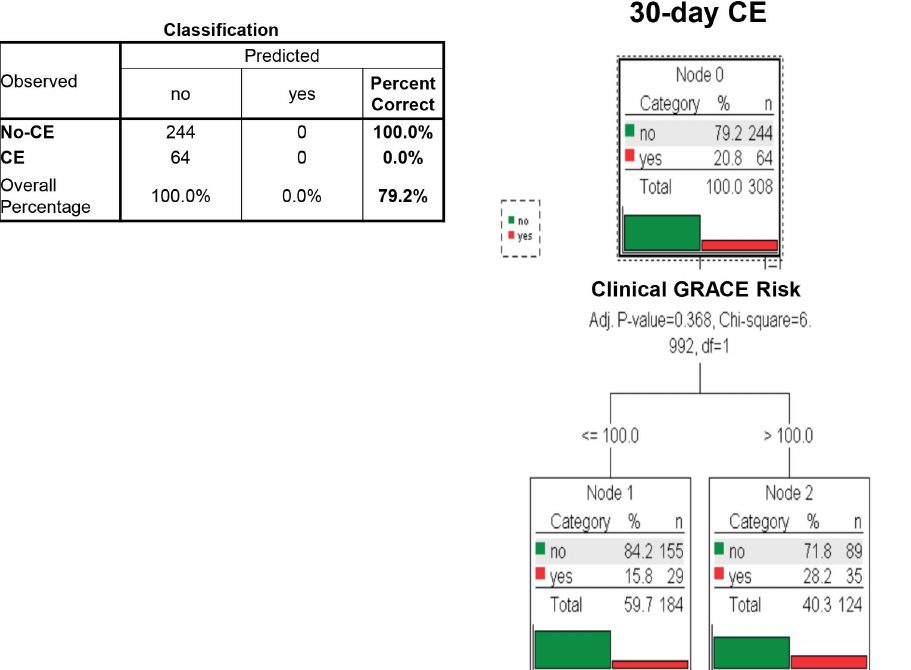
Figure 4. Multivariate classification tree analysis of clinical and multiple biomarker information and the resulting algorithm for the identification of those at risk of cardiac events (CE) within 30 days among patients presenting with suspected ACS and no apparent ST-segment elevations (Non-ST-elevation patients). No significant classification with regard to 30-day CE was possible using the clinical GRACE risk score (Bonferroni-adjusted p-value=0.368).